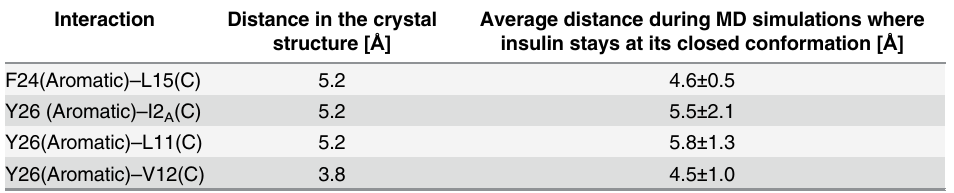
The distances were calculated from the center of the benzene ring (aromatic) to the nearest C atom. The same trajectory data as in Table 1 were used in calculating the average